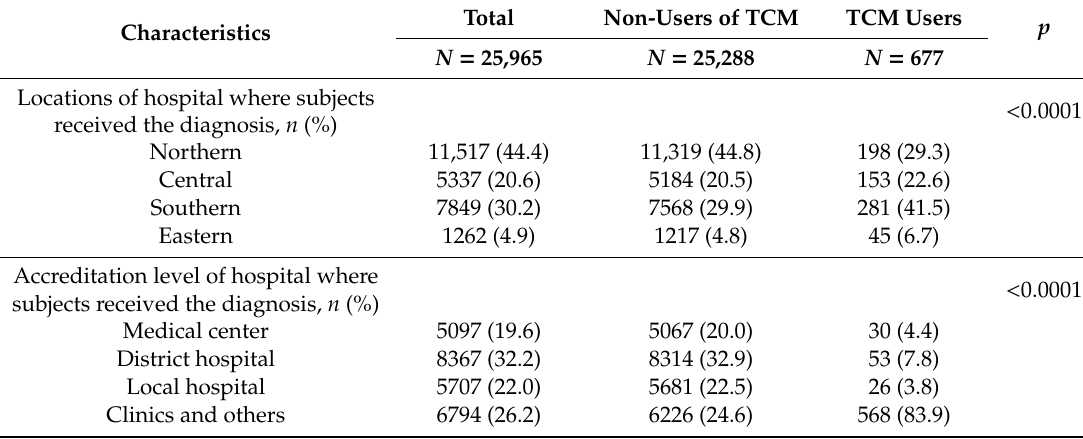
Table 2. Characteristics of hospitals where patients received medical care after their diagnosis of carpal tunnel